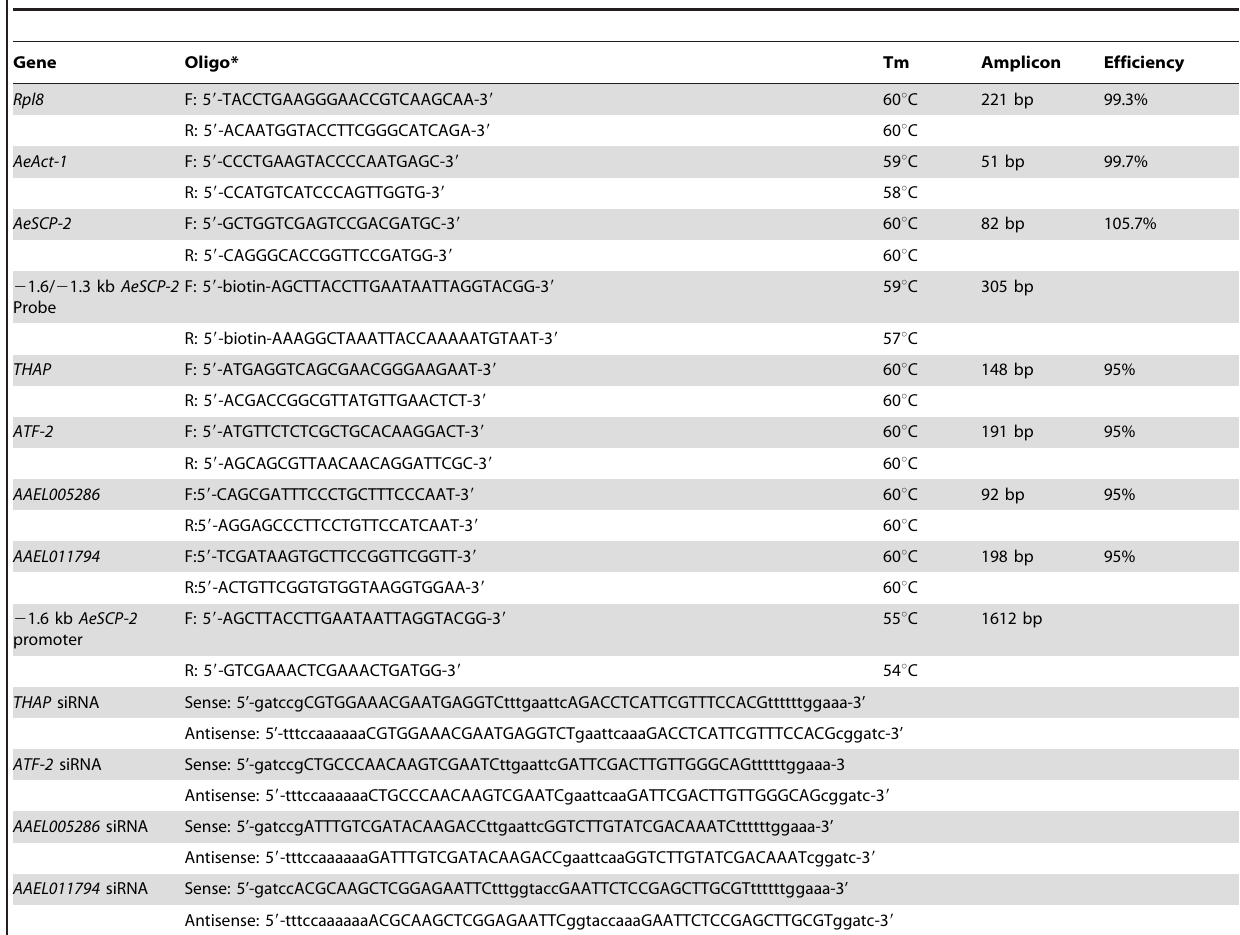
Table 2. Nucleotide sequences of primers for PCR and oligos for siRNA.